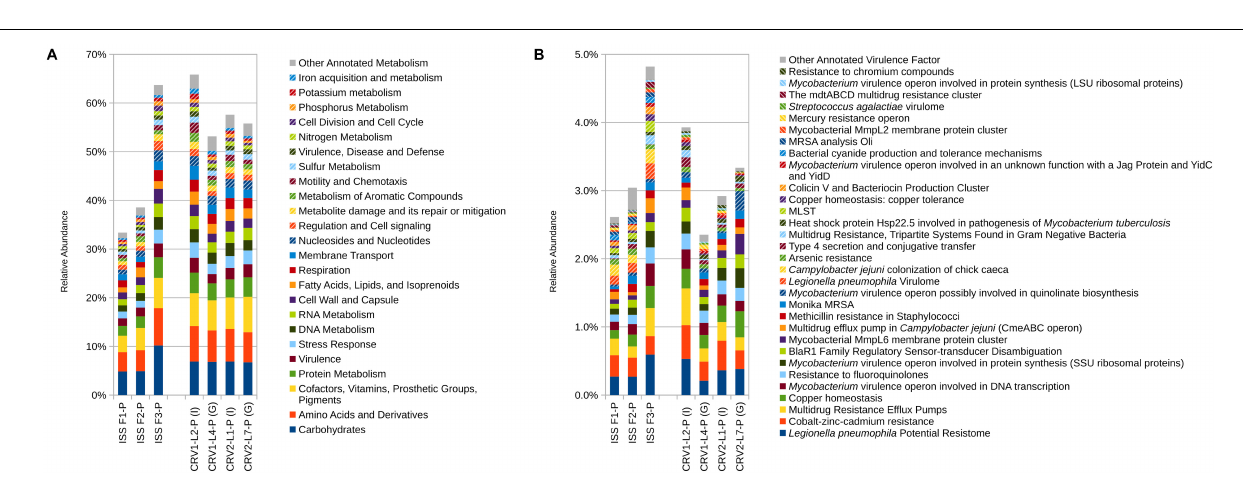
richness at the internal location. However, a completely opposite trend was observed for CRV2 where the GSE surface showed higher species richness and evenness as compared to the internal